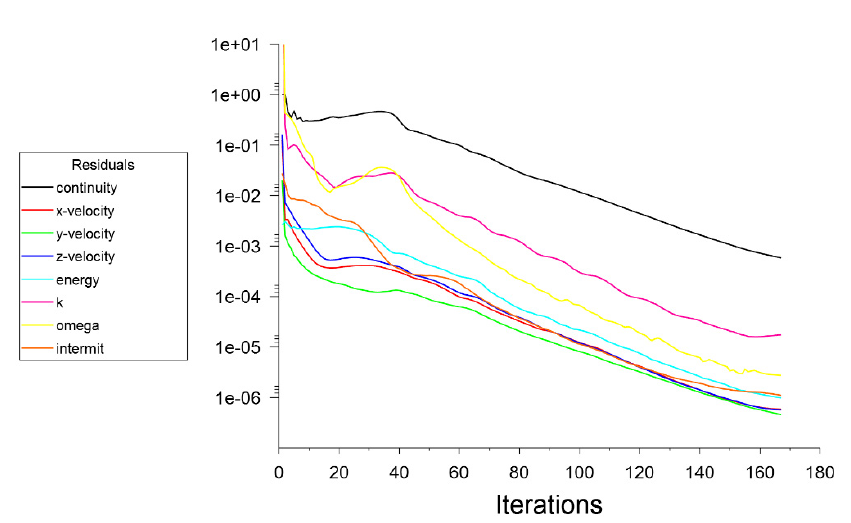
Figure A1. Vortex visualization by means of the isosurfaces of 𝜆 (cid:2870) criterion for 𝜆 (cid:2870) = − 4.89e9 s − 2 , col- ored by z-component of vorticity. Blue areas indicate right-handed and red left-handed vortex cores. ( a ) Tu = 0.1 %, ( b ) Tu = 5 %.